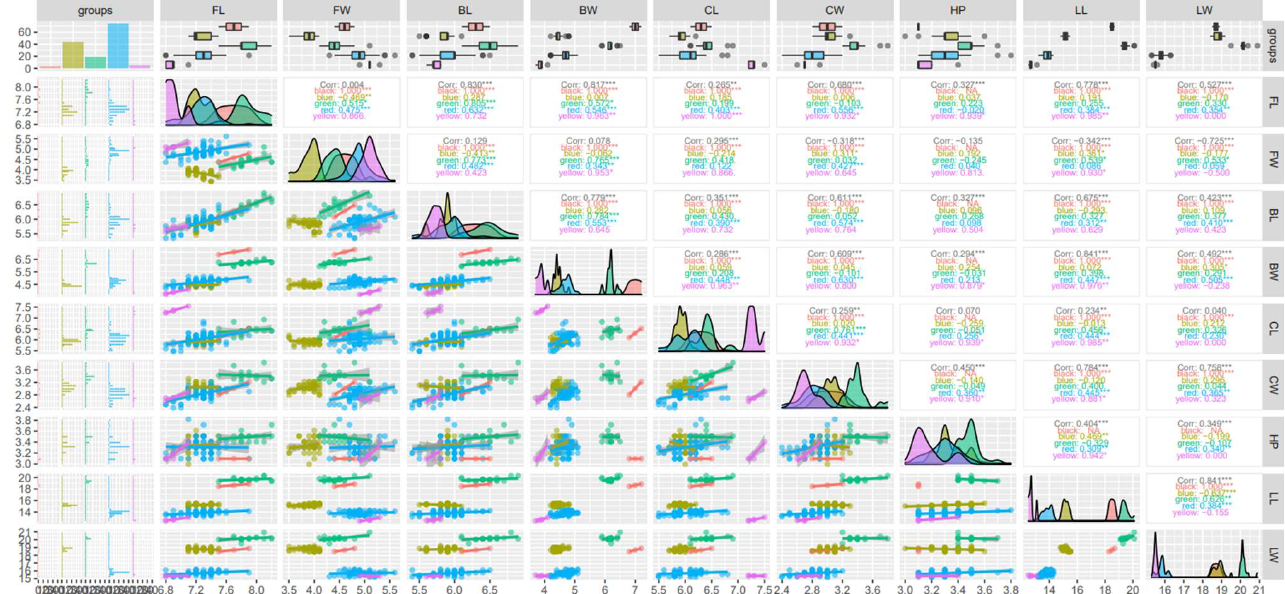
Figure 3. Pearson correlation and scatter plot obtained by comparing nine quantitative descriptors of five cotton groups [Blue ( G. barbadense L.), red ( G. barbadense L. var. brasiliensis ), green ( G. hirsutum L.), black (unknown group G1) and yellow (unknown group G3)] collected in the province of La Convención, in the districts of Echatari and Megantoni, Cusco-Peru. Flower length (FL, cm), flower width (FW, cm), bracts length (BL, cm), bracts width (BW, cm), capsule length (CL, cm), capsule width (CW, cm), plant height (HP, m), leaf length (LL, cm), and leaf width (LW, cm). Symbols *, **, and *** represent significant differences at 0.5, 0.1, and 0.01% probability, respectively.